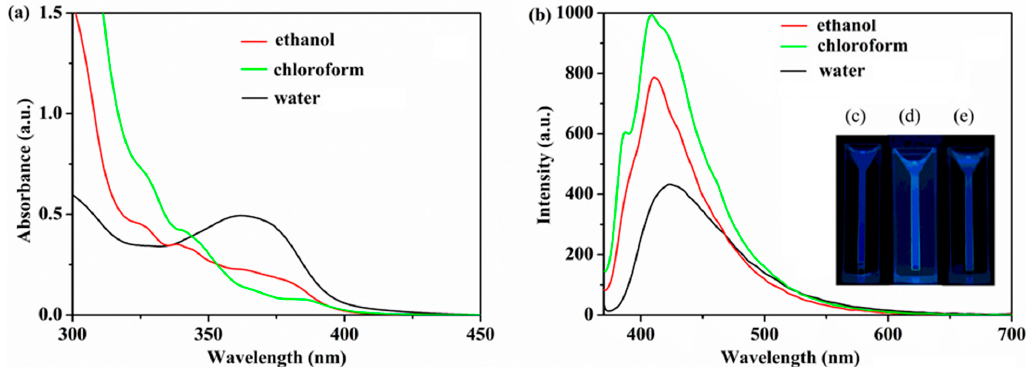
Figure 7. UV-Vis spectra ( a ) and PL spectra ( b ) of ZnO 1:2 /HPEI-10 nanocomposites which are dissolved in ethanol, chloroform and water, respectively. The inset ( c – e ) shows the photographs made under UV light of ZnO 1:2 /HPEI-10 nanocomposites which were dissolved in ethanol, chloroform and water, respectively.